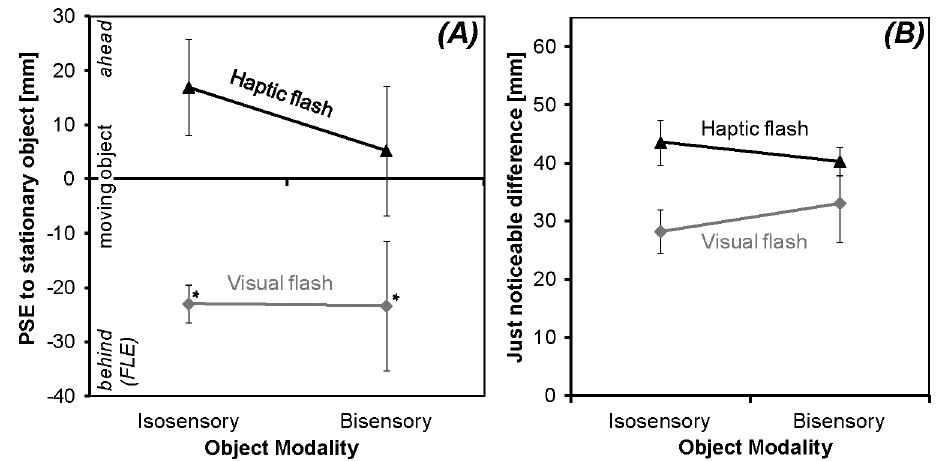
Fig 2. Results, first experiment. (A) Average point of subjectivelyequal position of the moving object to the non-moving, stationary object (PSE) and (B) judgment precisionas assessedby JNDs computedfrom flash onset position for visual and haptic flashes combinedwith isosensory(visual or haptic) and bisensory(visuo- haptic) objects. A significantnegative PSE (marked by an asterisk) indicatesa flash-lageffect. Error bars represents standard errors of the